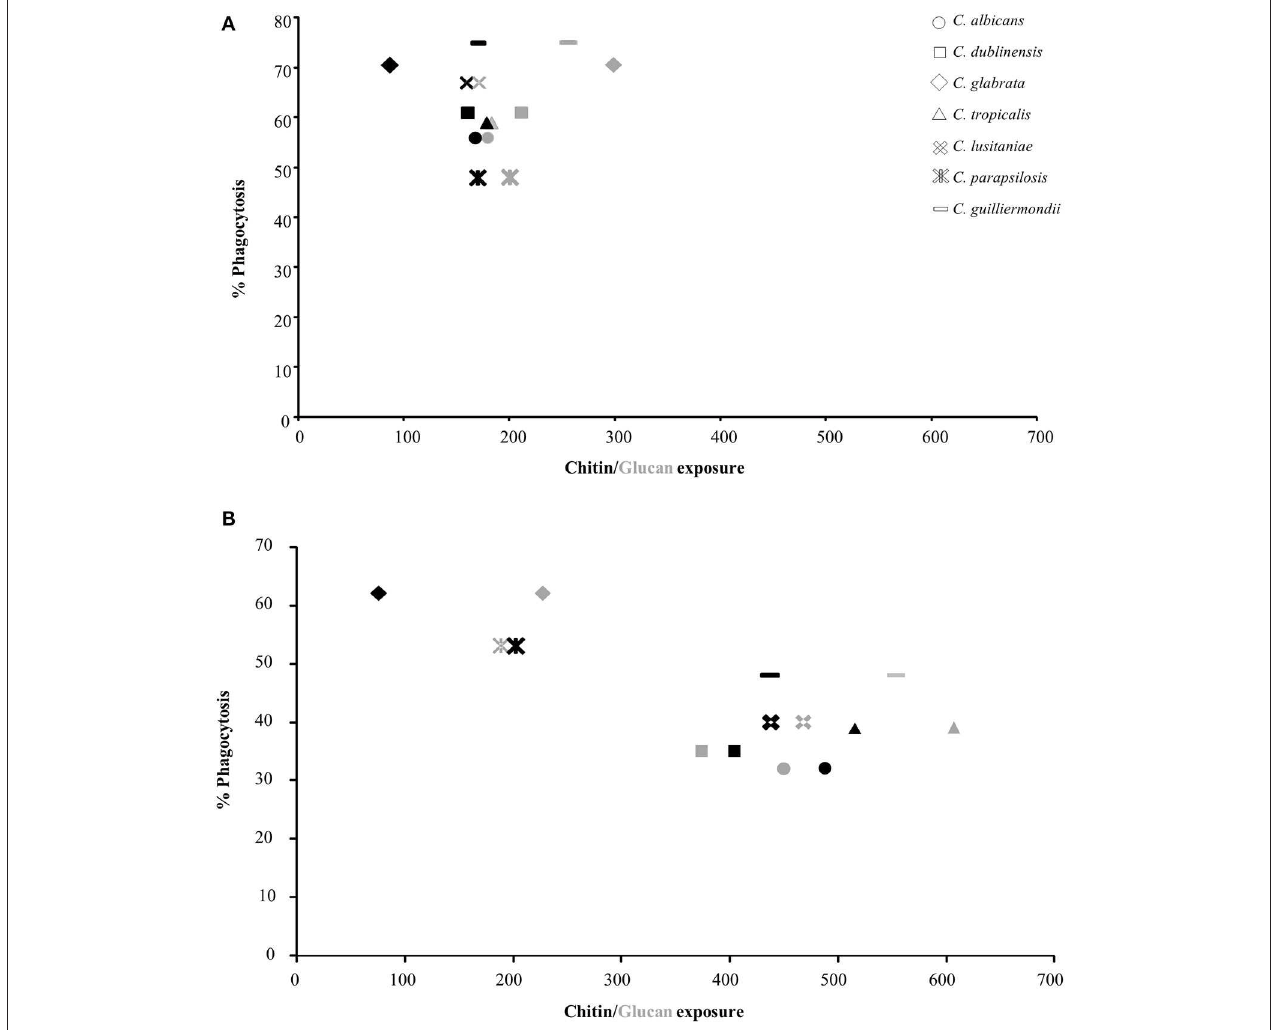
FIGURE 2 | Correlation between exposure of chitin and glucan on the cell surface of Candida species and phagocytosis by J774 macrophages. The values for exposure of chitin and β -1,3-glucan were taken from Table 5 . Phagocytosis of Candida spp. by macrophages was determined by fluorescence microscopy. All cells were stained with 10 µ g/ml FITC prior to exposure to macrophages. FITC-stained cells were exposed to J774 macrophages for 1h, after which non-phagocytosed cells were stained with 25 µ g/ml CFW. The number of macrophages which had phagocytosed Candida cells were then counted ( n = 300). (A) Untreated Candida spp. cells. (B) CSF treated Candida cells. Black shapes = chitin (WGA-TR), gray shapes = glucan